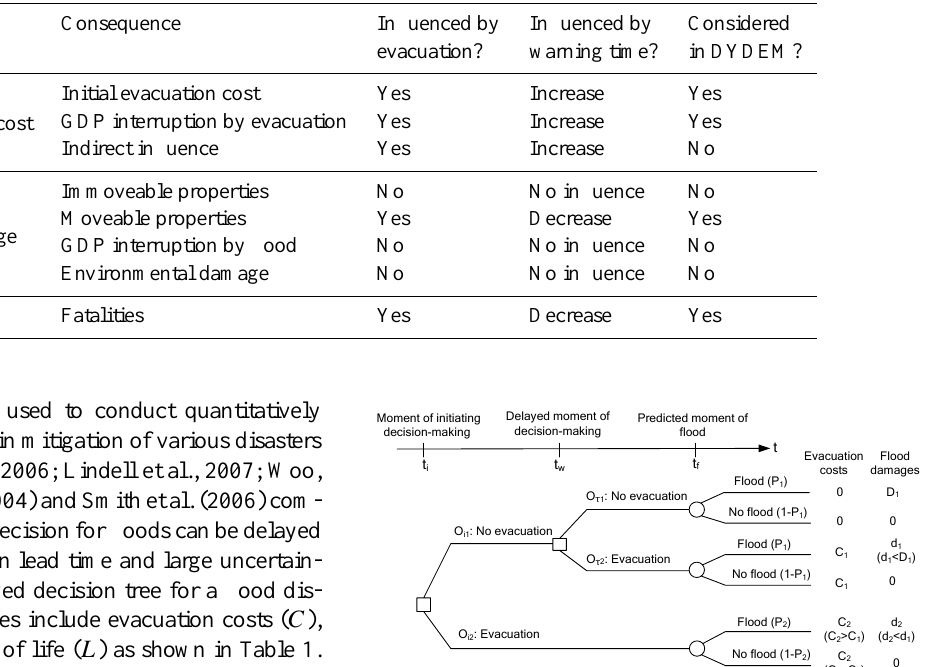
Table 1. Flood consequences